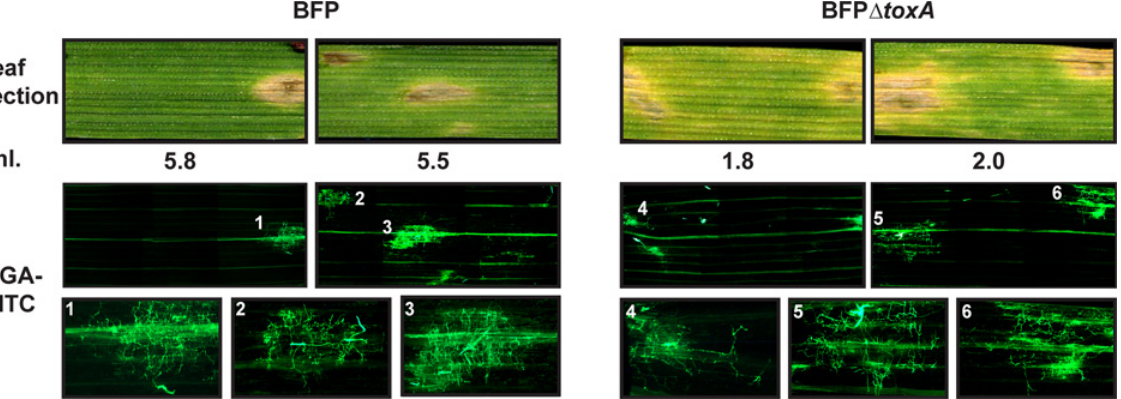
Fig 4. Mycelial growth in planta is restricted to lesions in BFP and BFP Δ toxA inoculated ‘ TAM 105 ’ . One centimeter leaf sections harvested from BFP and BFP Δ toxA inoculated leaves 6 days post inoculation were scanned (Leaf section), chlorophyll concentration estimated (Chl.), and mycelia stained with WGA-FITC. Stained leaves were imaged with a fluorescent microscope and the whole leaf image is a montage of 6 separate panels that cover the entire 1 cm leaf section. The bottom row represents increased magnification images of select (numbered)